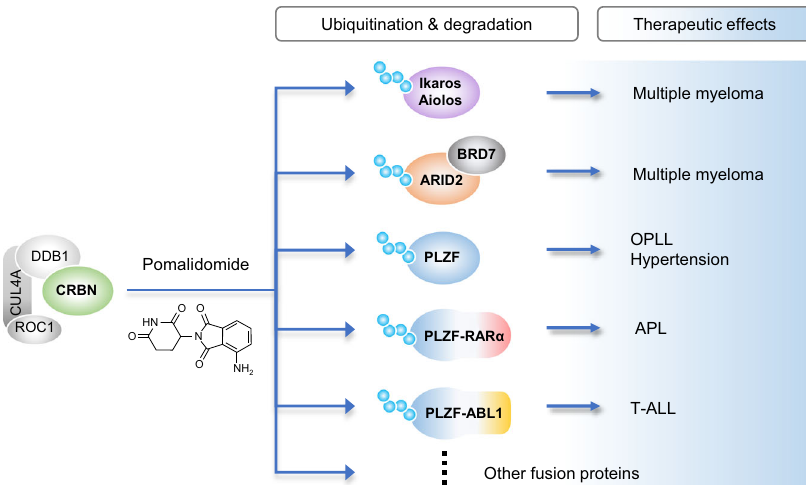
Fig. 6 Schematic representation of pomalidomide effects. In multiple myeloma, pomalidomide induces the degradation of Ikaros, Aiolos, and ARID2, resulting in anti-myeloma effects. Pomalidomide also induces degradation of PLZF and may exert several physiological and pathological effects via its breakdown. In APL and T-ALL expressing PLZF fusion proteins, pomalidomide may exert an anti-cancer effect by inducing the degradation of the leukemogenic fusion